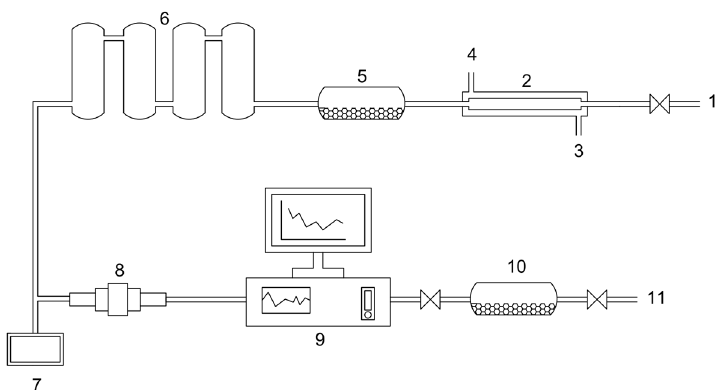
Figure 2. Diagram of the cooling system, cleaning and analysis of the gases coming out of the furnace. 1. Gas inlet. 2. Heat exchanger. 3. Coolant inlet. 4. Coolant outlet. 5. CaSO 4 dehumidifier. 6. Particle settler. 7. Pressure transducer. 8. Particle filter. 9. DOAS gas analyzer. 10. Silica gel dehumidifier. 11. Gas outlet.